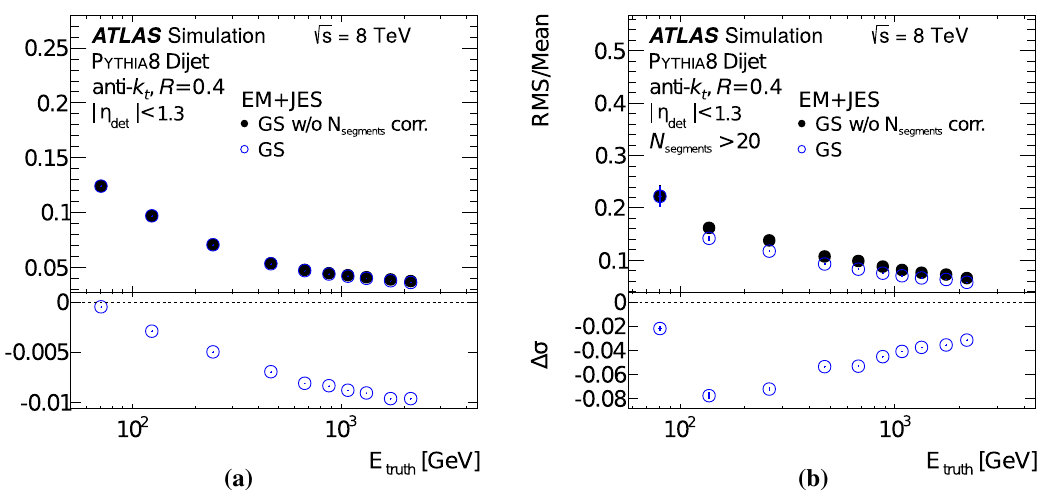
Fig. 11 Standard deviation over arithmetic mean of the jet energy response as a function of E truth for | η det | < 1 . 3 before (filled circles) and after (empty circles) the fifth global sequential correction for a all jets and b calorimeter jets with N segments > 20 in the nominal Pythia8 dijetMCsample.Alljetsarereconstructedwithanti- k t R = 0 . 4andini- tially calibrated at the EM+JES scale. The requirement N segments > 20